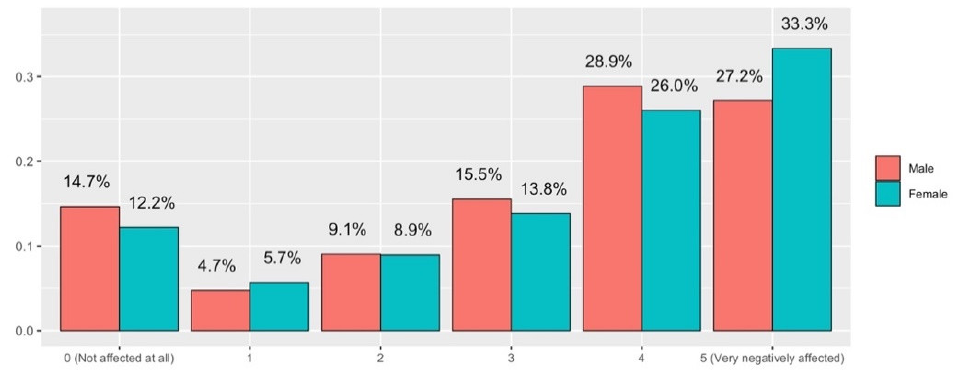
Figure 16. Answers to Q11 disaggregated by gender.